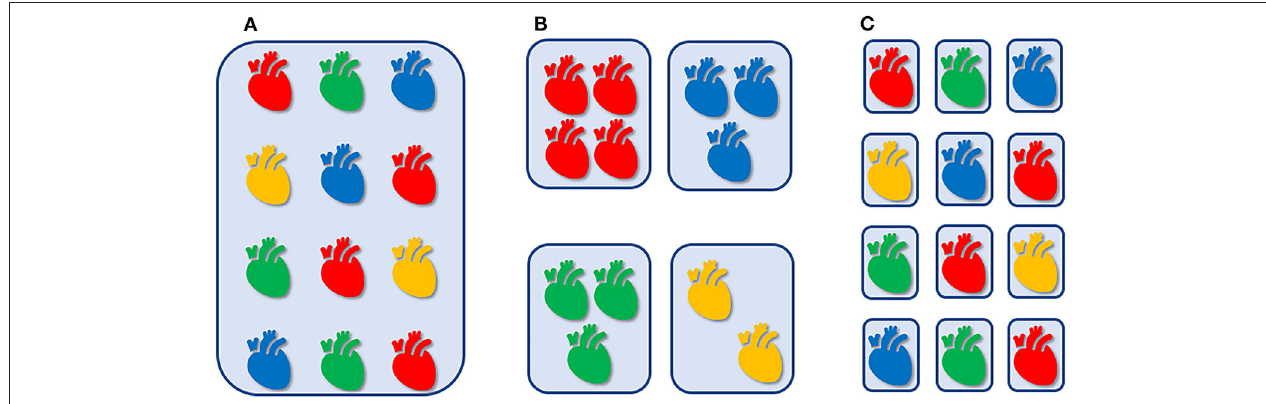
FIGURE 1 | Empirical, “one-size-fits-all” approach, irrespective of cardiovascular physiology and clinical context (A) . Hemodynamic management that is stratified by presumed underlying pathophysiology (B) . Individualized hemodynamic management that is tailored to the cardiovascular (patho-)physiology and the specific clinical characteristics of each individual patient (C)